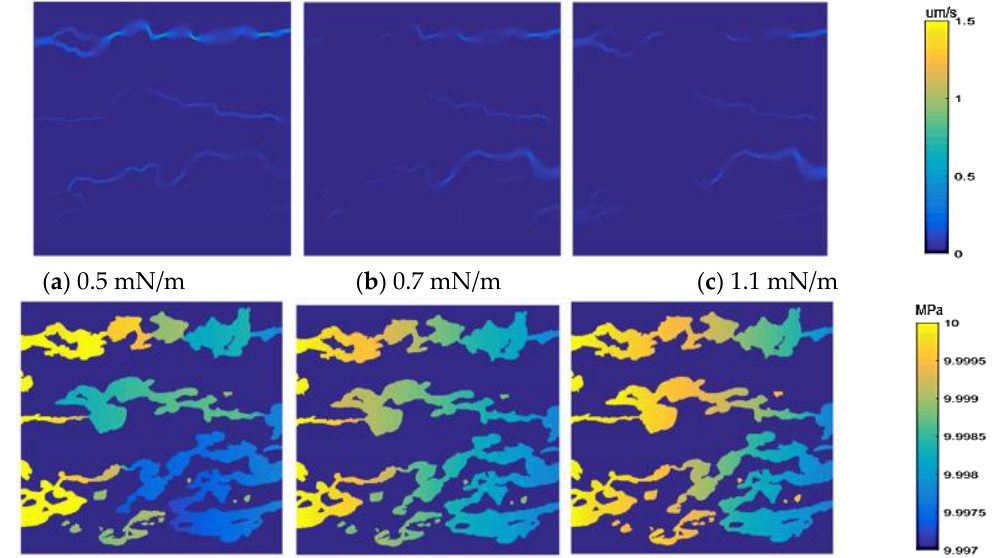
Figure 20. Simulation results under different interfacial tension. Figure 21 shows that as the viscosity of the oil phase increases, the starting pressure gradient of single-phase oil flow in the shale matrix increases.